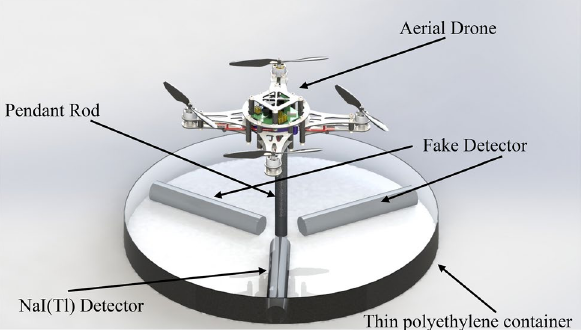
Figure 3. SolidWorks rendered graphical illustration of the conceptual design of gamma finder system (drawings is not to the scale).